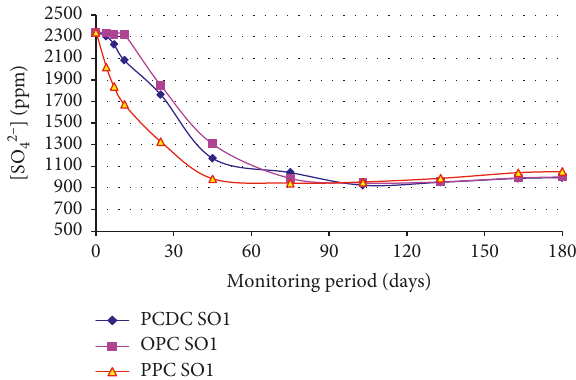
Figure 9: SO 42 analyses in sulphate-simulated solution 1. −